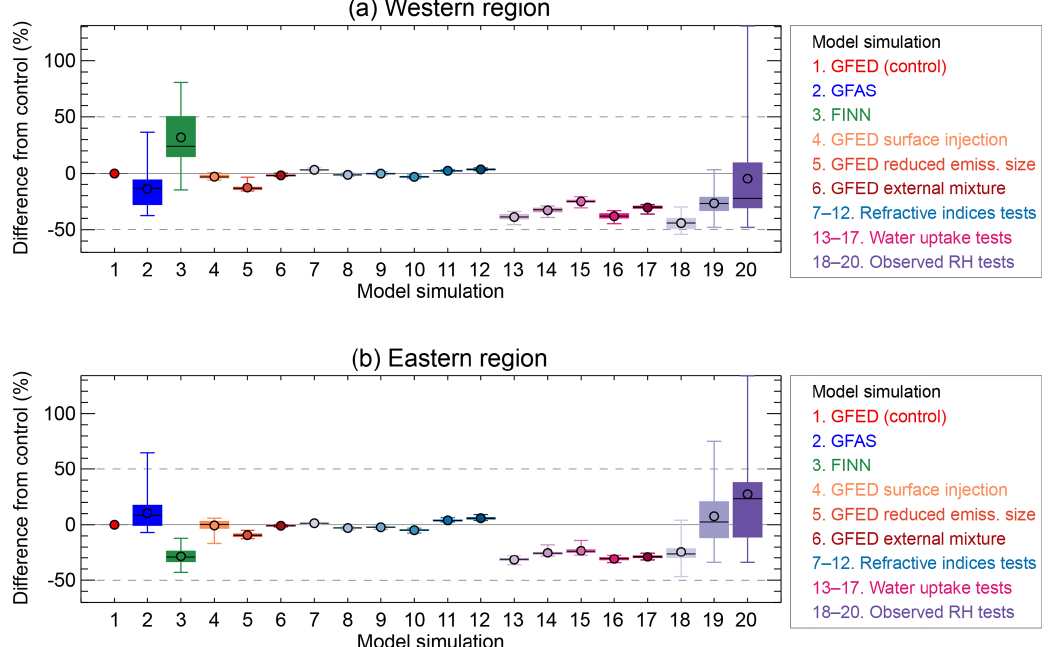
Figure 10. Box-and-whisker plot summarising the relative difference between simulated hourly mean AOD550 from the control simulation (GFED emissions with ZSR water uptake scheme) and each of the sensitivity simulations listed in Table 3. Simulation numbers in the figure correspond to the simulation numbers in Table 3. Simulations are compared during the SAMBBA campaign period (13 September– 3 October 2012) for the western region (6–12 ◦ S, 54–68.5 ◦ W; a ) and the eastern region (4.5–15 ◦ S, 43–50 ◦ W; b ) separately. Simulations 18, 19 and 20 are compared to the control simulation only on days with available aircraft measurements of RH. Circles show the mean values, whiskers show the minimum and maximum values, boxes show the 25th and 75th percentiles, and horizontal lines show the median